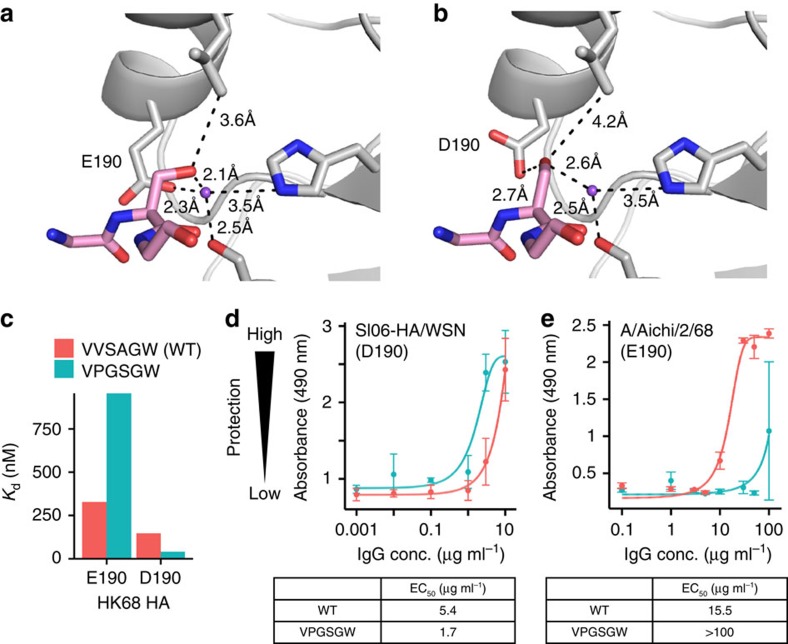
E190D in the HA RBS favors binding against VPGSGW.The hydrogen bond network involving S100d of the CDR H3 of VPGSGW is shown for (a) binding against HA RBS of HK68/H3, and (b) binding against HA RBS of HK68/H3 that carried mutation E190D, which is modelled based on the crystal structure of VPGSGW-HK68/H3 HA1. A putative sodium ion is represented by the purple sphere. For visual clarity, only G100c, S100d, G100e, and W100f on the Fab are displayed. (c) The affinities of WT C05 Fab (VVSAGW) and a C05 Fab variant (VPGSGW) against the HA from A/Hong Kong/1/1968 (wild type: E190; E190D mutant: D190) are shown as a bar chart. (d,e) The neutralizing activity of WT C05 and VPGSGW in IgG format against (d) SI06-HA/WSN virus, and (e) A/Aichi/2/68 virus were measured by cell viability assay. SI06-HA/WSN virus was generated based on WSN, in which the HA ectodomain was replaced by that from SI06 (see Methods). Colour code is the same as that of c. Mean value across three replicates is shown and the error bar represents the s.d. The large error bar in VPGSGW at 100 μg ml−1 against A/Aichi/2/68 virus is due to complete protection in one but not in the other two replicates.